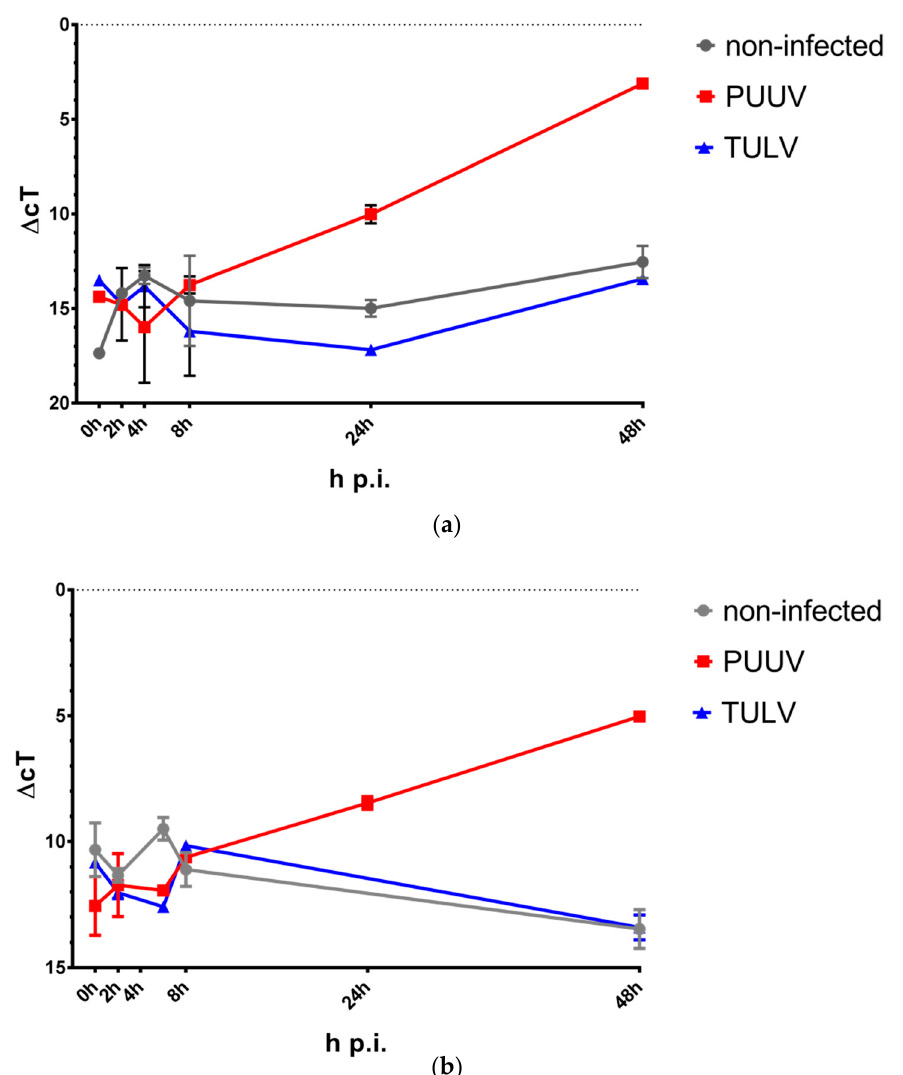
Figure 4. IFNB1 gene expression in response to infection. Expression of the IFNB1 gene was quantified in response to PUUV or TULV infection of ( a ) HMEC-1 or ( b ) THP-1 cells via qRT-PCR and normalized to the expression of the cellular MYC gene. Cells were infected using a MoI of 1.0 and lysed at the indicated time points. No IFNB1 expression was detectable at 24 h p.i. in non-infected or TULV-infected THP-1 / PMA